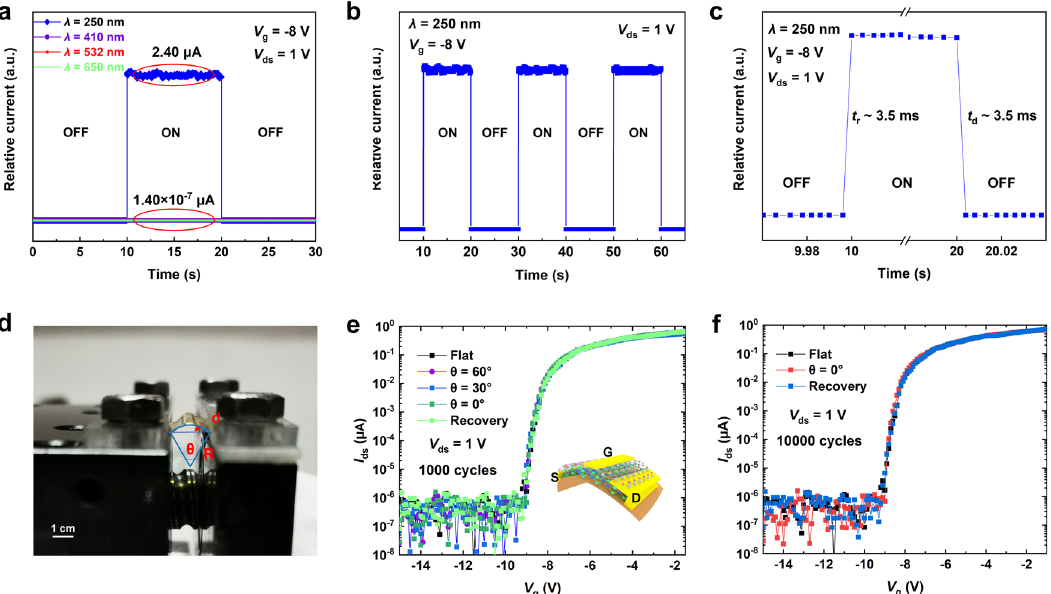
Fig. 4 The time response and stability properties of the fabricated β -Ga 2 O 3 phototransistor. a Time-dependent photoresponse of β -Ga 2 O 3 device under different wavelengths at V ds = 1 V and V g = − 8 V. b Time-dependent photoresponse of β -Ga 2 O 3 device under 250 nm excitation wavelength at V ds = 1 V and V g = − 8 V. c Enlarged view of the rise and decay edges of the curve in b . d The real image of the bending state of the displayed fl exible β -Ga 2 O 3 device with a prede fi ned bending angle. e Transfer curves of the device after the device is folded 10 3 cycles at different angles. f Transfer curves of the device after the device is folded 10 4 cycles at